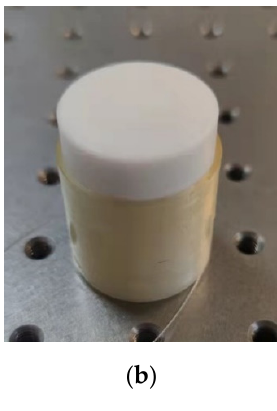
shown in Figure 9.